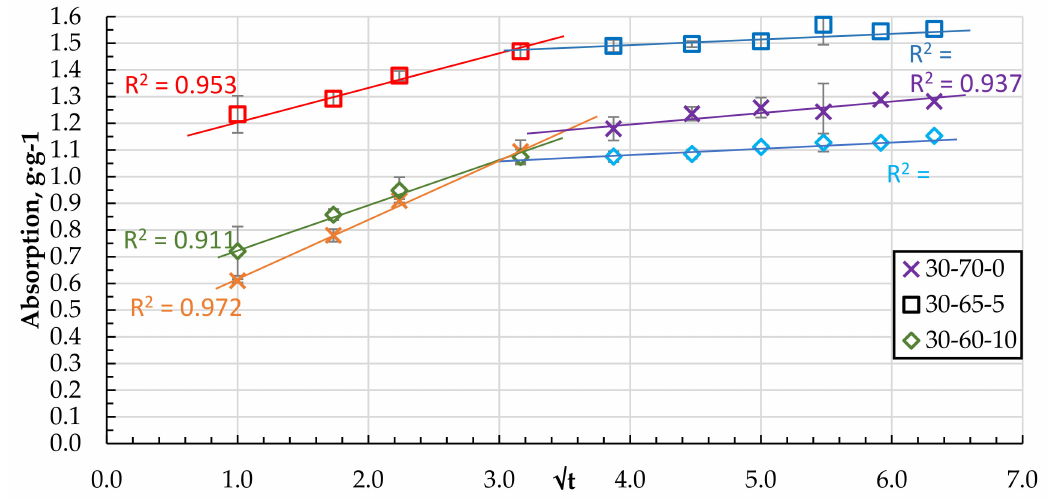
Figure 12. Absorption of DF in q t − t 0.5 coordinates for the granules with 5 and 0 wt.% of CSand HP only.